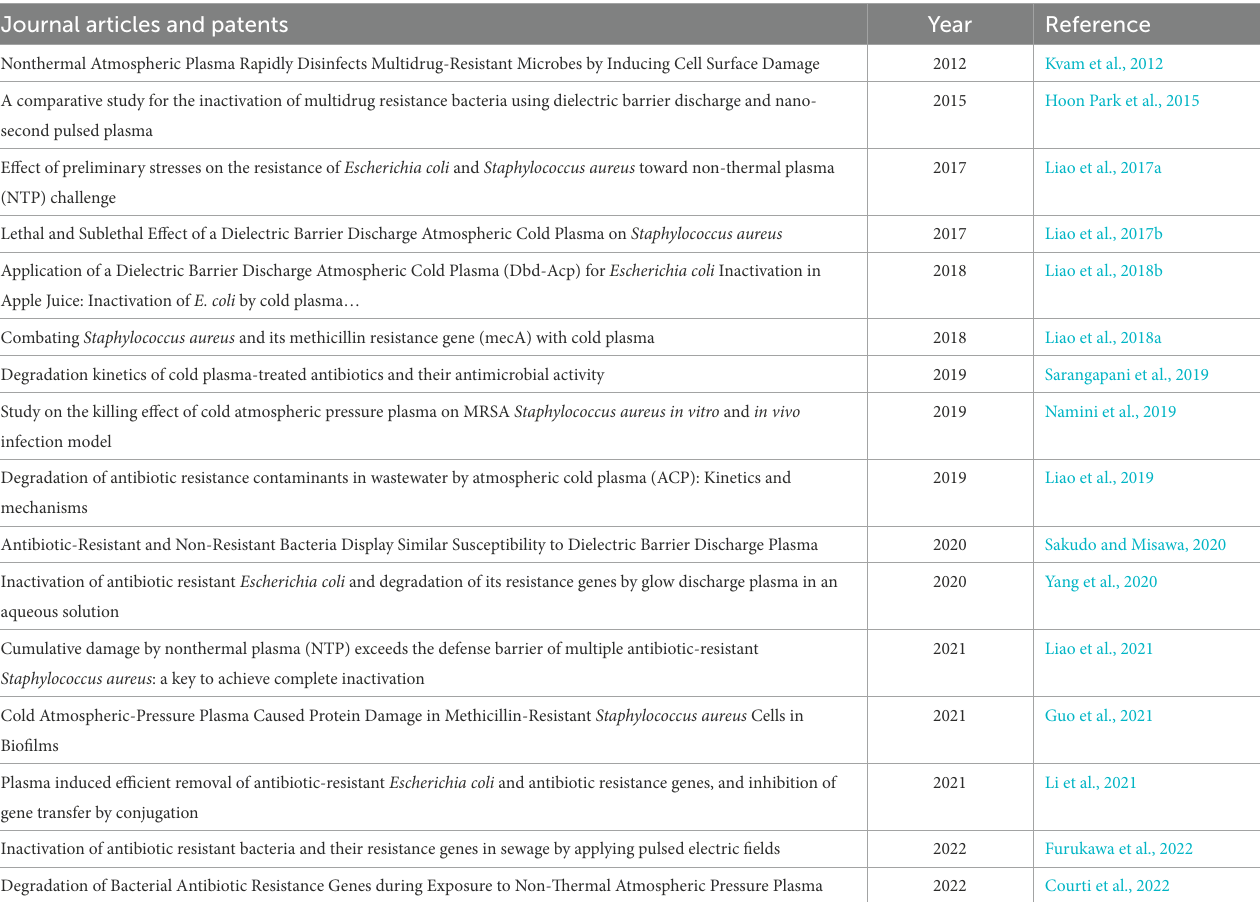
TABLE 7 Sample of studies done using CAP for treatment of wastewater.